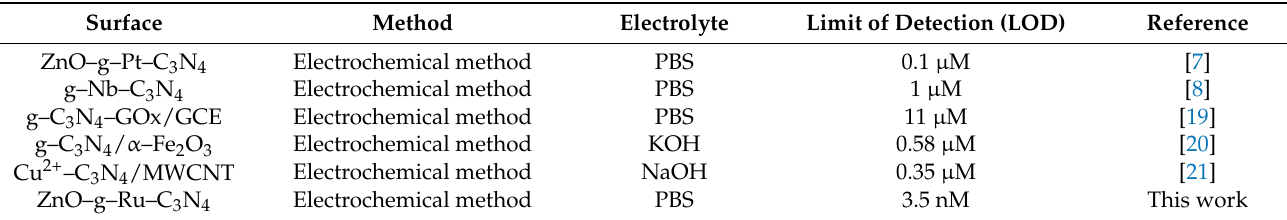
Table 1. Carbon nitride-based glucose sensing system.